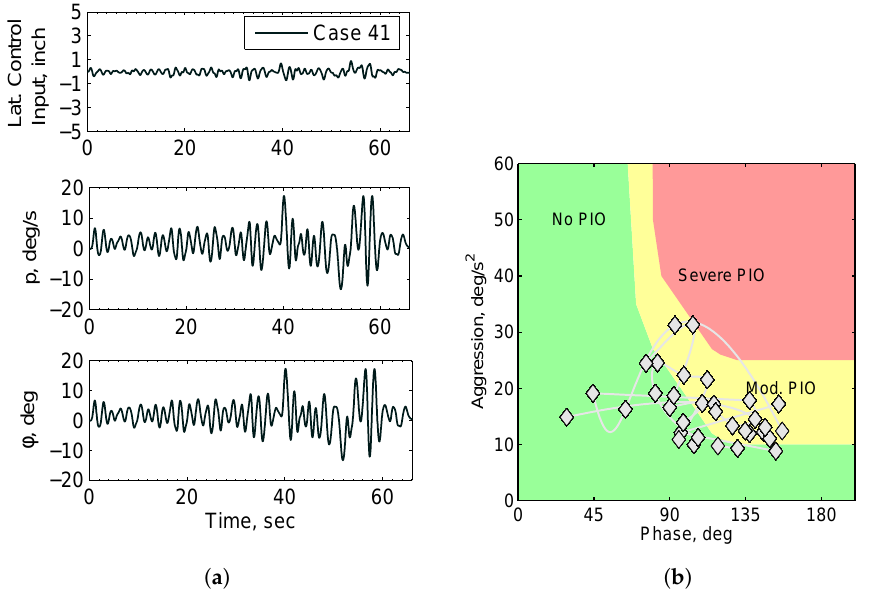
Figure 16. Results from lateral reposition-Case 41, Day 2-APC = 4B. ( a ) Time recording; ( b ) PAC results.